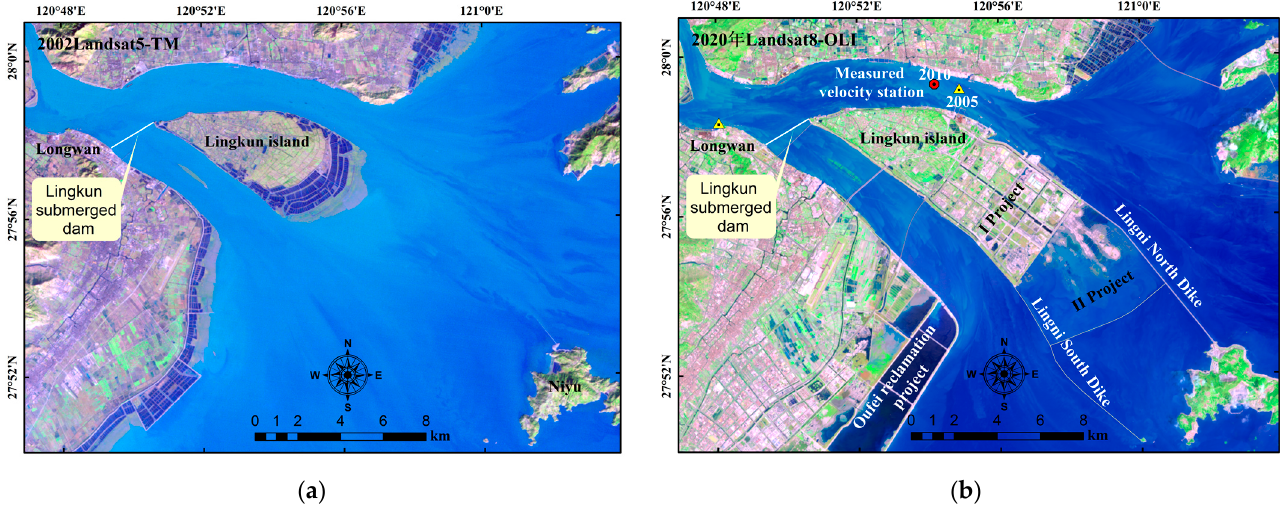
Figure 11. Remote sensing image of the Oujiang Estuary in different ages: (a) Landsat5-TM in 2002;